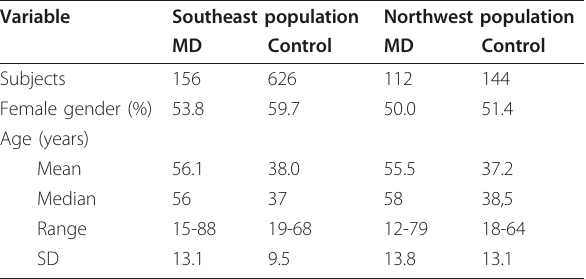
Table 1 Baseline characteristics of case and